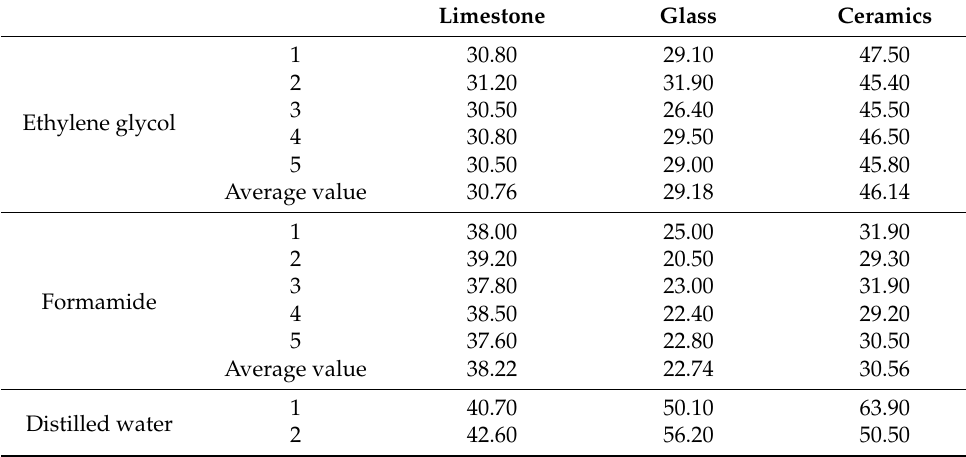
Table 6. Aggregate contact angle results ( ◦